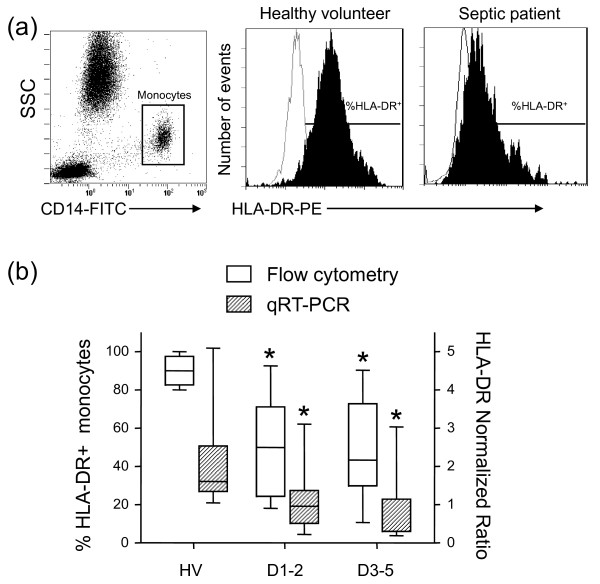
HLA-DR expression in septic shock patients and healthy controls. (a) Cell surface expression of HLA-DR measured by flow cytometry. A representative CD14 versus side-scattered light (SSC) dotplot and representative HLA-DR linear histograms gated on monocytes in one healthy volunteer and one septic patient (white histogram = isotype control). (b) Boxplot representations of mHLA-DR measurements by flow cytometry and quantitative reverse transcription (qRT)-PCR (white boxes, percentage of HLA-DR-expressing monocytes; dashed boxes, normalized ratio of HLA-DRA mRNA level relative to the housekeeping gene peptidylpropyl isomerase B) measured in whole blood or mononuclear cells from septic shock patients or healthy controls (n = 10). Values were measured at days 1 to 2 (D1-2, n = 7) and days 3 to 5 (D3-5, n = 10) for septic patients. Normal values: >90% for flow cytometry and 2 ± 0.3 for mRNA expression. Comparison versus healthy volunteers' (HV) values (means) performed using the Mann-Whitney U test with correction for the number of tests performed: *P < 0.025. mHLA-DR values expressed as the number of bound antibodies per cell (AB/c) were 15,985 ± 2,331 at D1-2 and 11,057 ± 2,691 at D3-5 in patients (>15,000 AB/c as indicative of immunocompetence [28]).